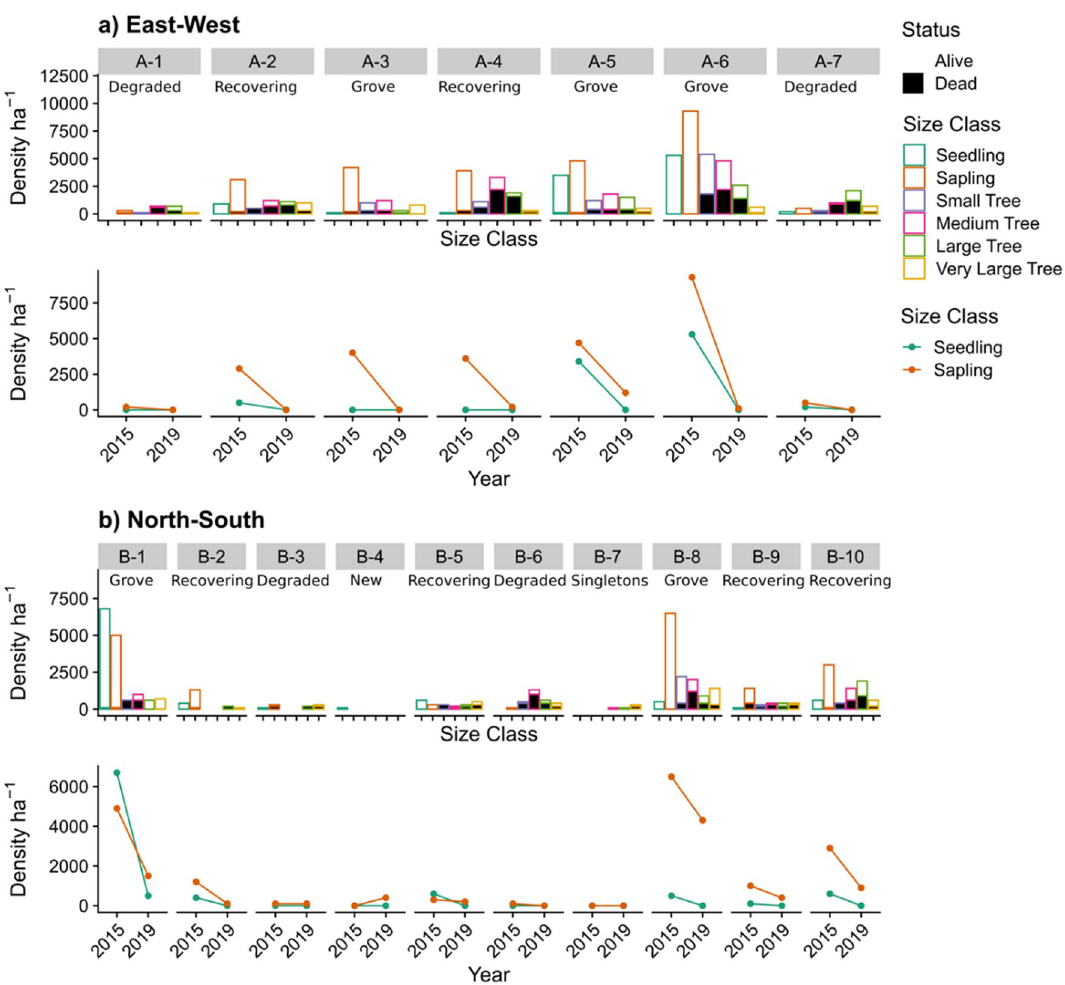
Figure 5. Size class distributions and status of Callitris intratropica stands in 100 m segments of the two transects ( a , b ) at the Dukaladjarranj Aboriginal estate in central Arnhem Land. Also shown are changes in the density of seedlings and saplings between 2015 and 2019 (Fig. S4). Seedlings (green) and saplings (orange) are respectively defined as < 0.1 m tall and 0.1 to 2.2 m tall. Seedlings, saplings and trees were counted within bands 2 m, 25 m and 25 m either side of the transect midline, respectively. Size classes are defined as: seedlings (< 0.1 m tall), saplings (0.1 to 2.2 m tall), small trees (≥ 2.2 m tall and < 10 cm D 1.0 ), medium trees (10 to 20 cm D 1.0 ), large trees (20 to 30 cm D 1.0 ) and very large trees (≥ 30 cm D 1.0 ). Stand status in each segment was defined as healthy groves (multiple live trees in most size classes, well outnumbering dead trees); degraded (a few live trees in larger size classes, with a high proportion of dead trees and few saplings or seedlings); recovering (similar to degraded, except with multiple seedlings and saplings); singletons (very few trees, mostly alive); and new (seedlings and/or saplings